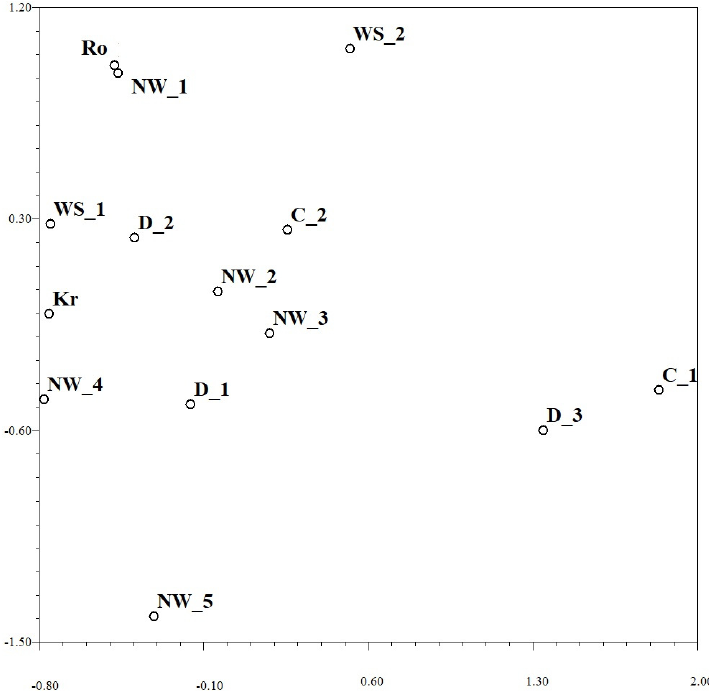
Figure 2. Non-metric multi-dimensional scaling plot based on the KB distance with regard to the simple mismatch dissimilarity between Puccinia striiformis collections of pathotypes from different regions. Abbreviations of regions and subgroups: Kr—Krasnodar, Ro—Rostov, D—Dagestan, NW—North-West, WS—West Siberia, and C—Central European regions; NW_1 means the first subgroup in NW region. Table 7. Pairwise distances ( KB ; below diagonal) and significance of differentiation ( KW ; above